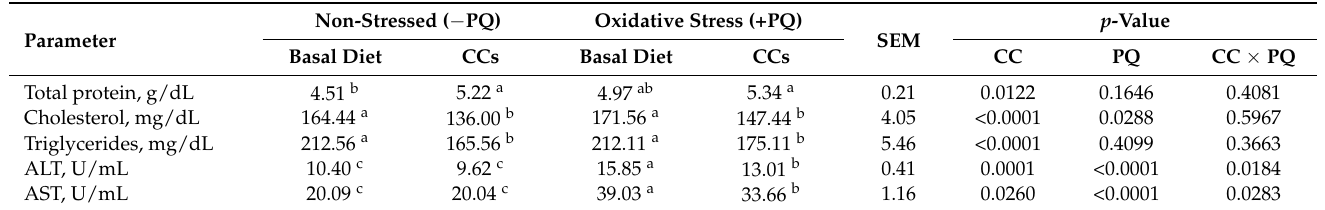
Table 7. Blood metabolite and liver enzyme activity of layers subjected to paraquat-induced oxidative stress (PQ) and dietary Citrullus colocynthis seed supplementation